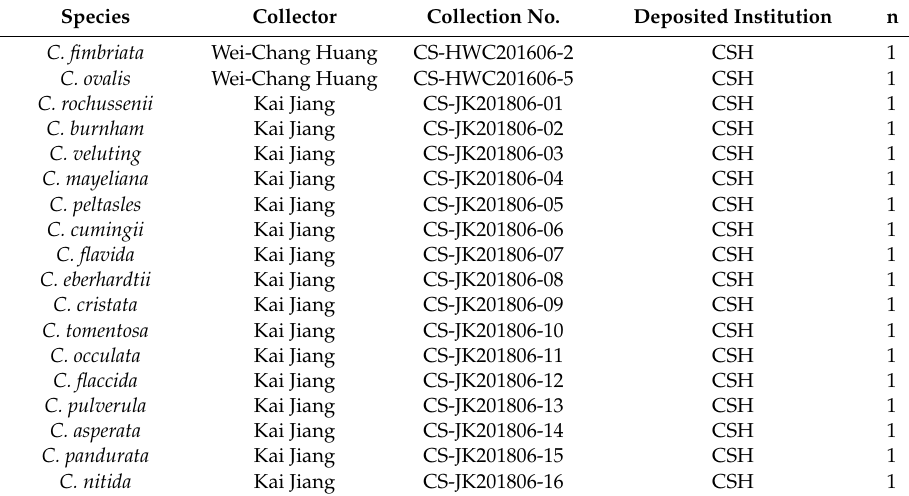
Table A2. Specimen Information for the Coelogyne Spp. Samples Used in This Study. Species